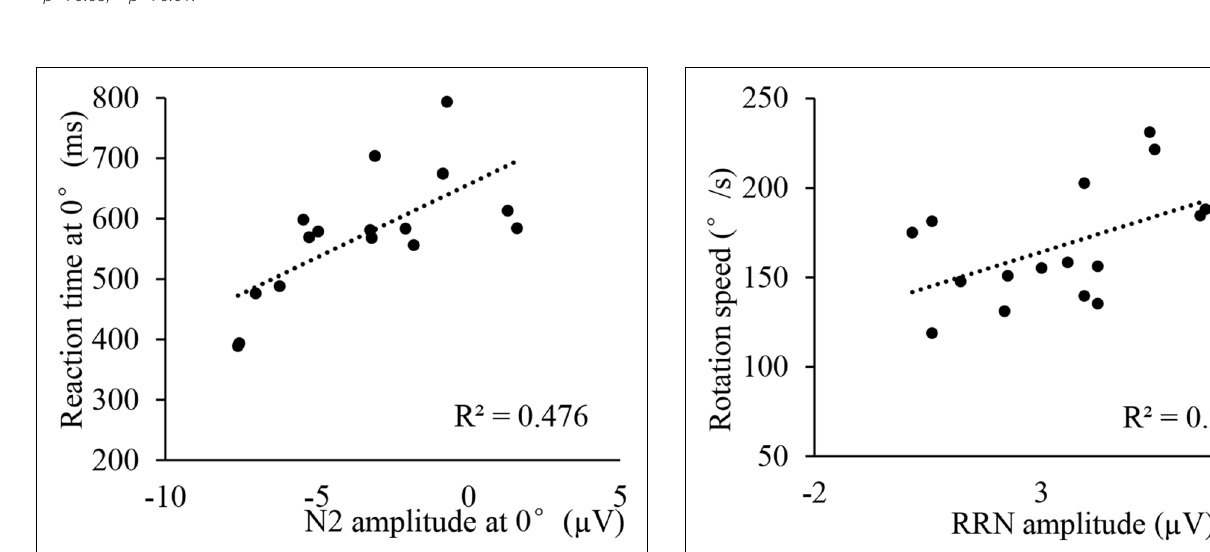
FIGURE 8 | Correlation between RRN amplitude (P3) and rotation speed for athletes ET